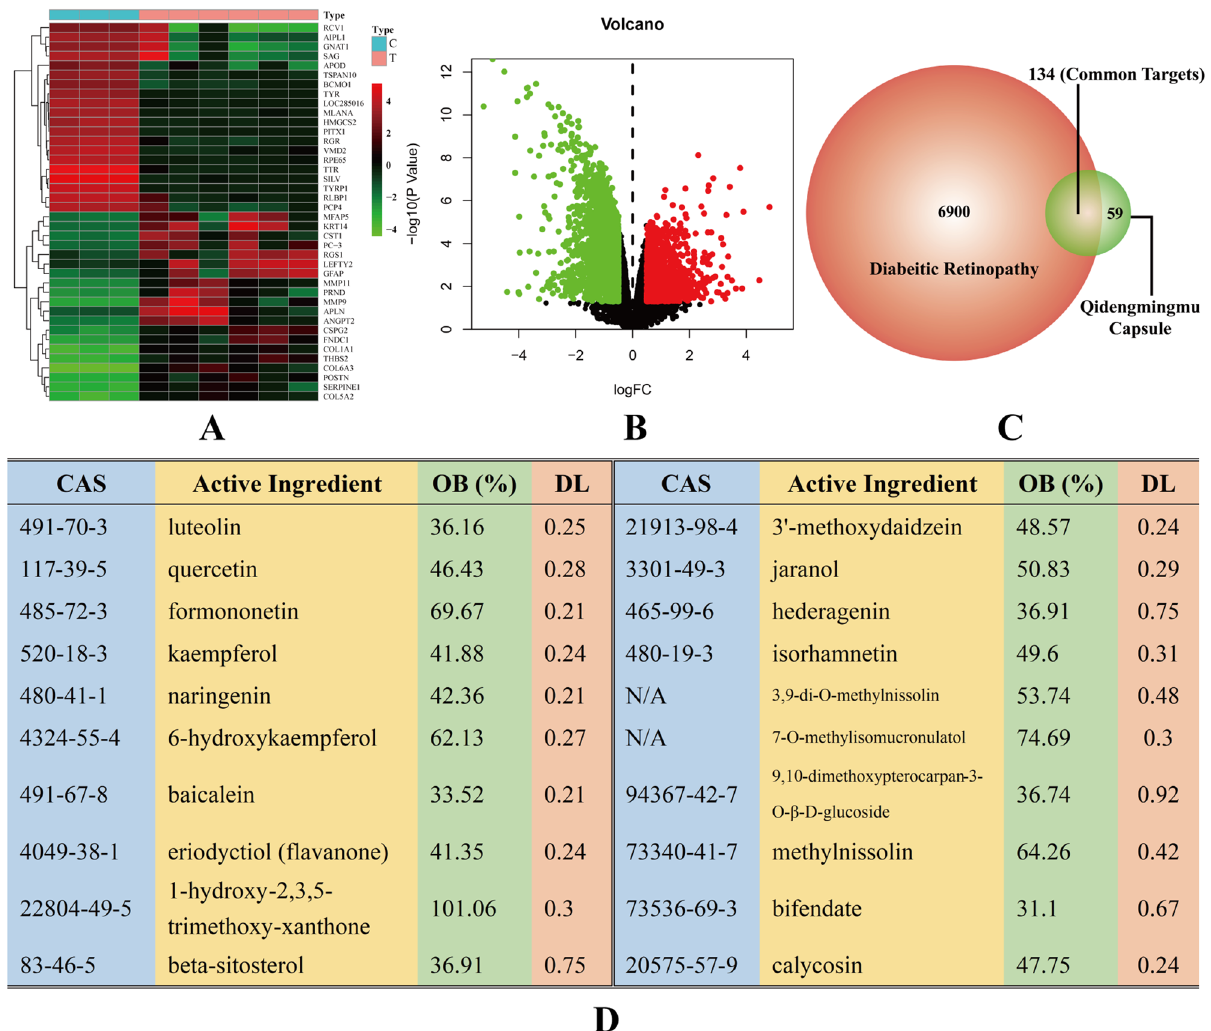
Figure 1. Screening of QC-DR common targets and active ingredients. ( A ) Heatmap of the results from a BeadChip gene expression dataset (GSE60436) in the NCBI-GEO database. Red and green boxes are used to represent upregulation and downregulation, respectively; the control and test groups (Type) are shown in sky blue and carnation. ( B ) Volcano plot of BeadChip gene expression data (GSE60436). Red and green dots are used to represent upregulation and downregulation, respectively; black dots represent nonsignificant changes. ( C ) Venn diagram of QC-DR common targets. ( D ) Details about the active ingredients of QC involved in the treatment of